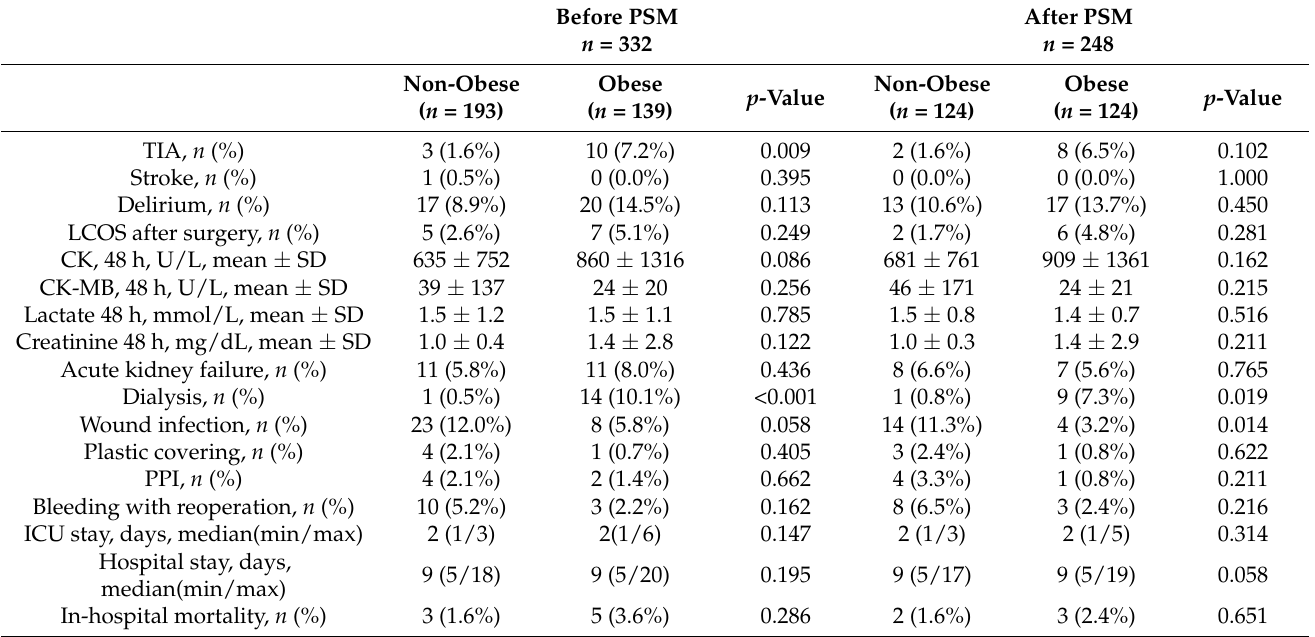
Table 3. Postoperative